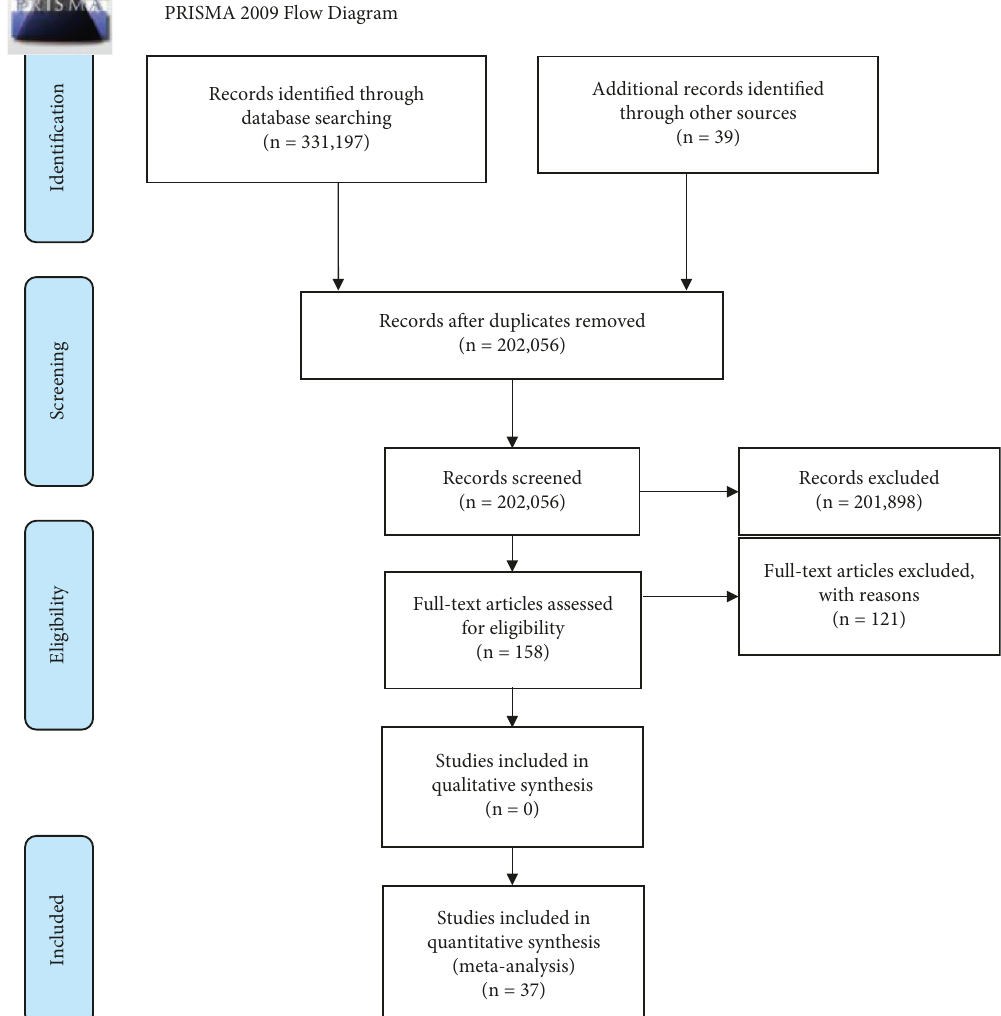
Figure 1: Preferred reporting items for systematic review and meta-analysis, June